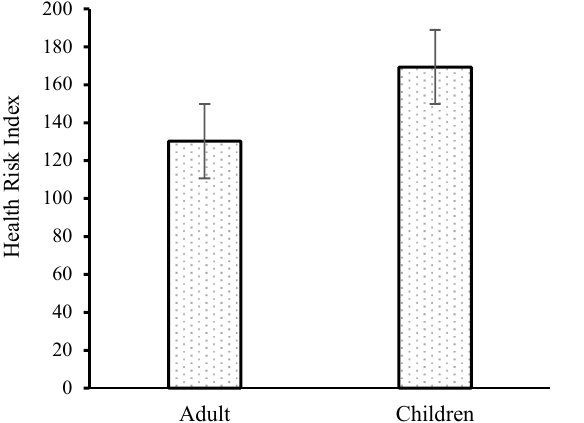
Fig. 1. HRI for nickel accumulation in wheat